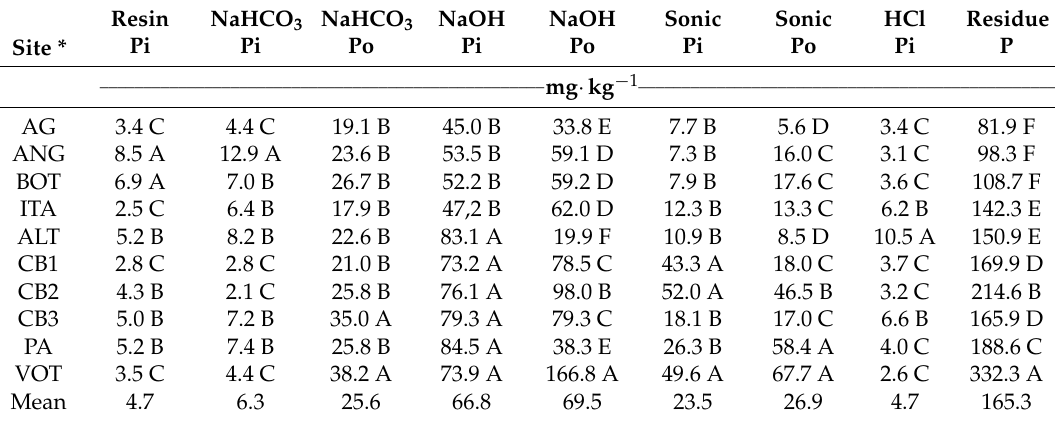
Table 3. P fractions of soils (0–20 cm) under Brazilian Eucalyptus plantations.